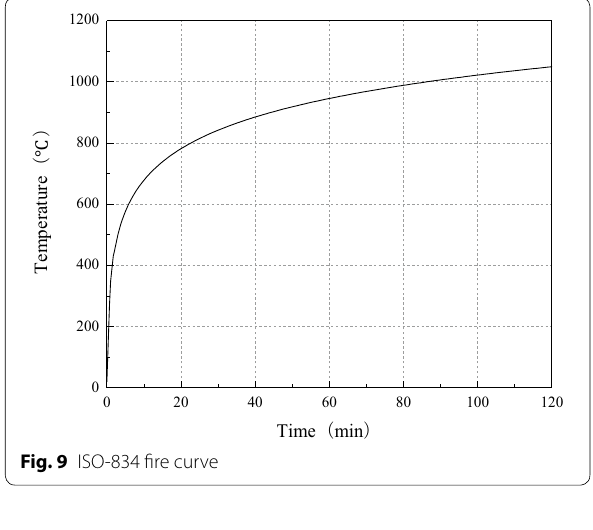
Fig. 11 Temperature field nephogram of the beams after 1 h of fire